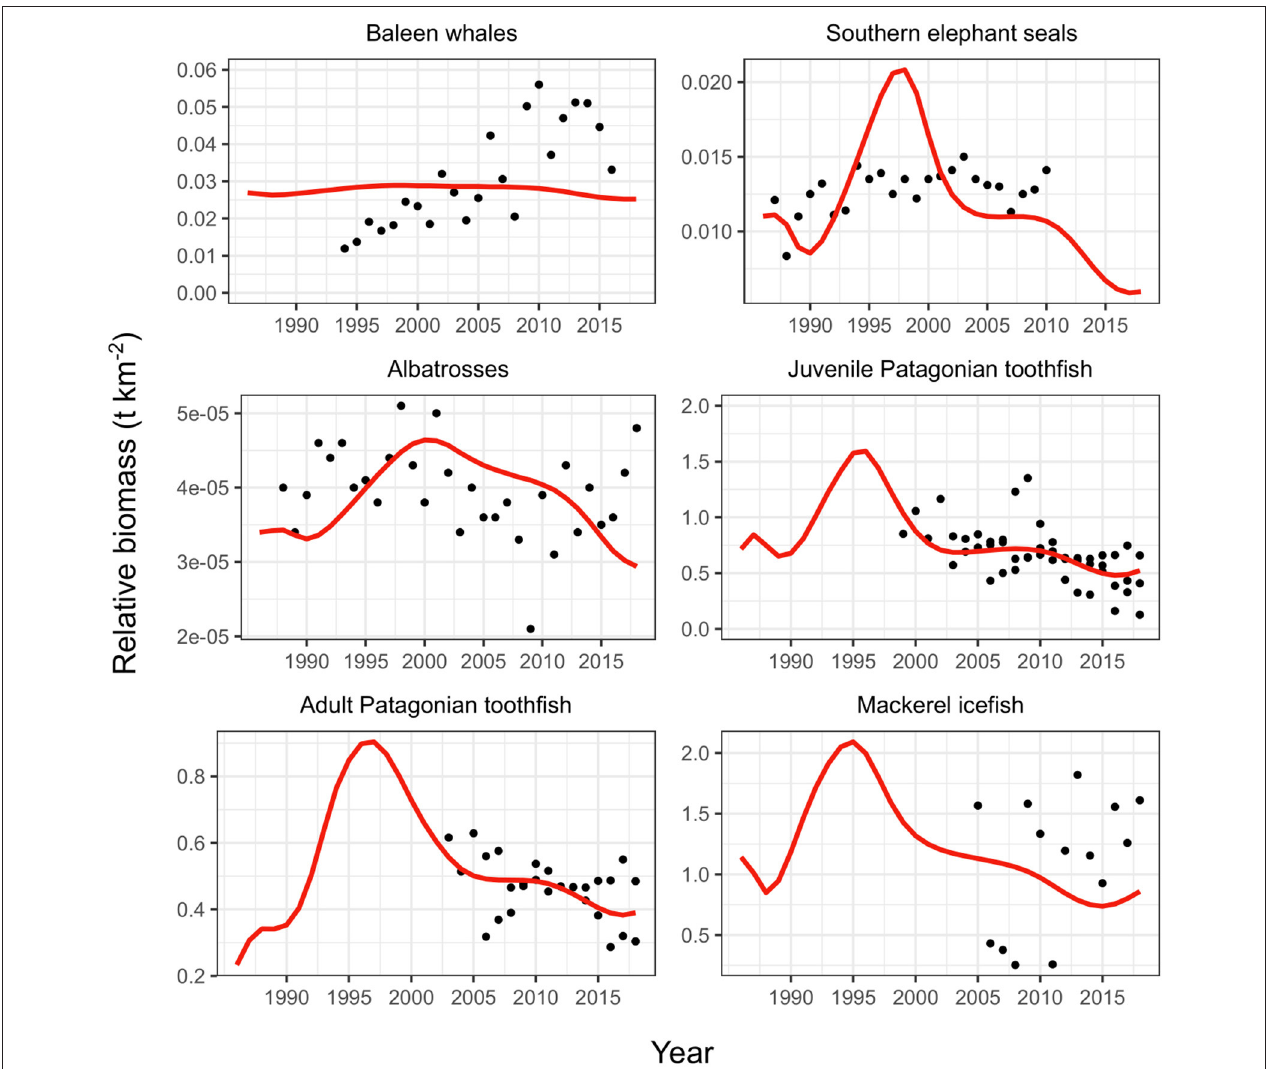
FIGURE 4 | Fit of model to observations with replaced vulnerabilities (Table 2) . Red line shows model fit, black points show observations. Toothfish observations are three CPUE inputs as described in Table 1